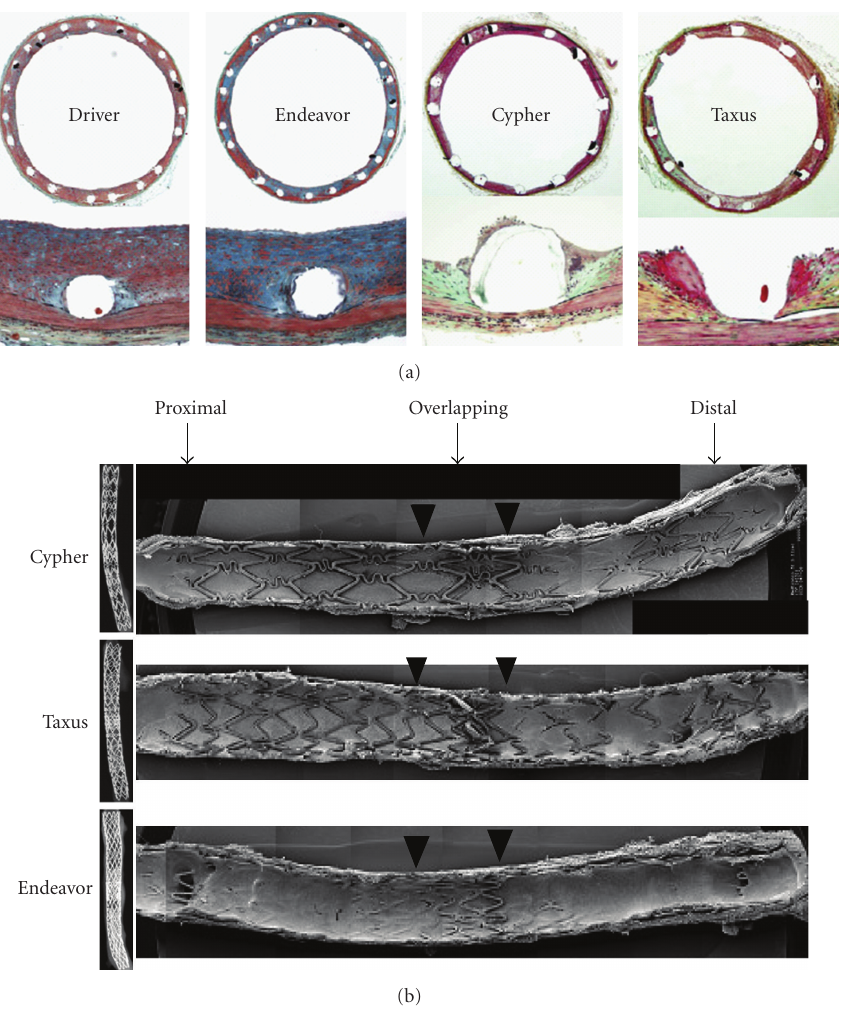
Figure 5: (a) X-rays of longitudinally cut rabbit iliac arteries at 21 days after placement of overlapping ZES, SES, and PES. The extent of stent coverage by endothelial cells was greatest with ZES, with almost complete coverage in the proximal and distal segments and significantly greater coverage in the overlapped segment compared with SES and PES. (b) Photomicrographsshowing the amount of neointimalthickness at 28 days after placement of Endeavor zotarolimus-eluting stents (ZESs), Cypher sirolimus-eluting stents (SESs), Taxus paclitaxel-eluting stents (PESs), and Driver bare metal stents (BMSs) in rabbit iliac arteries. With SES, there were focally uncovered stent struts, which were associated with inflammation consisting of heterophils or eosinophils and giant cells. Adapted from